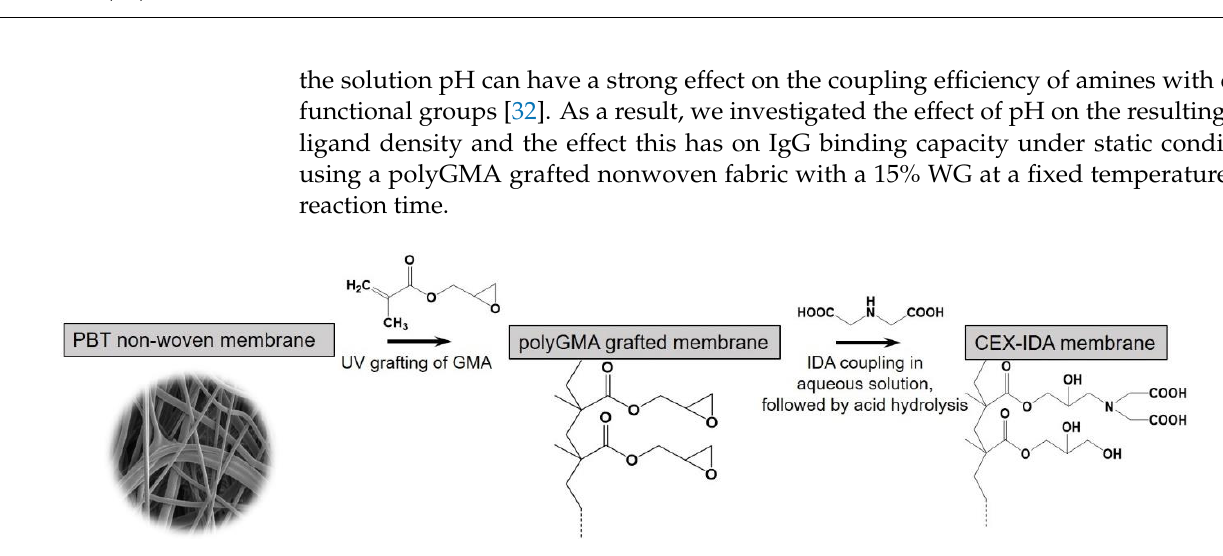
Figure 1. Schematic diagram of CEX-IDA membrane preparation.